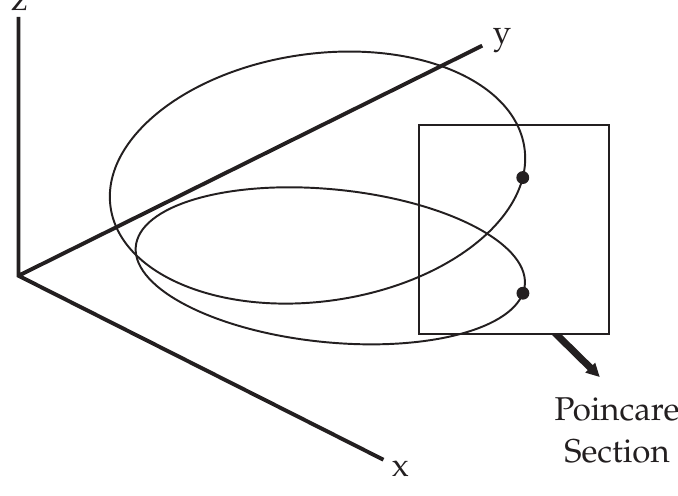
Figure 8. Graphical representation of calculating stroboscopic distribution by finding the points of intersection of the phase trajectories with the Poincare